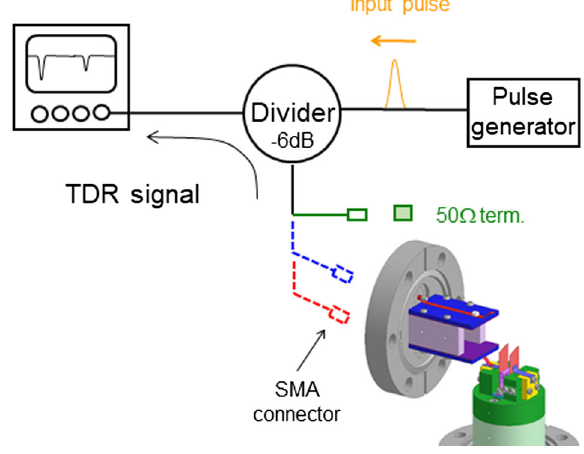
FIG. 3. Experimental setup of the TDT.